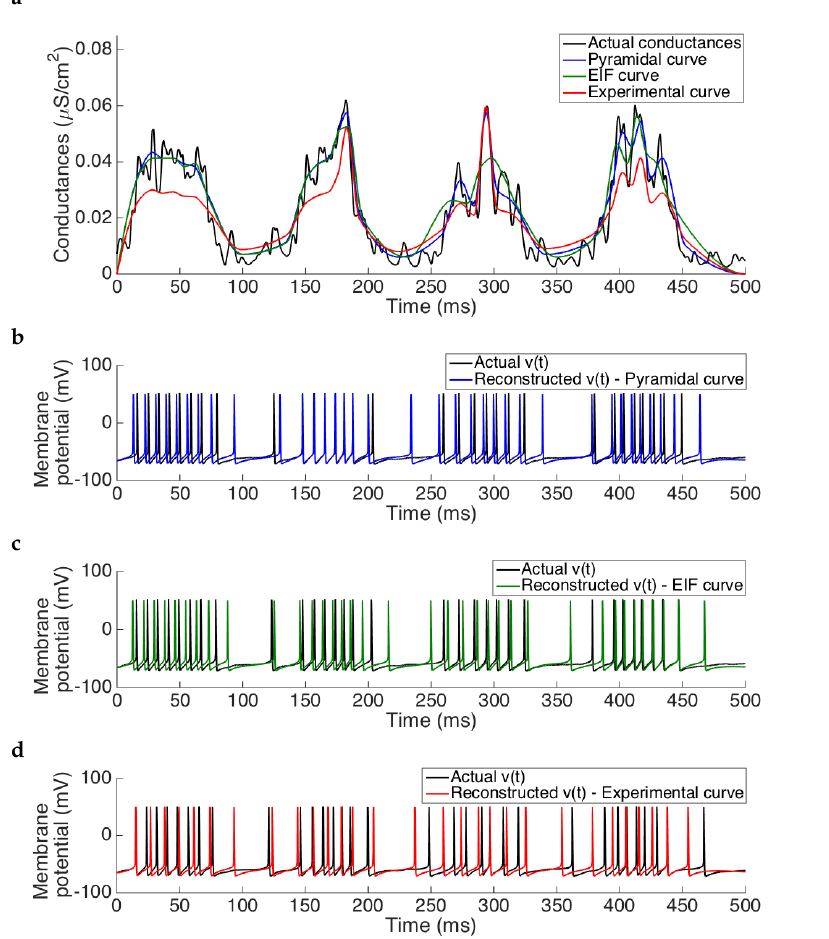
Figure 8. Results of the estimation procedure applied to a non-tonic membrane potential from a noisy pyramidal cell model. Panel ( a ) shows the prescribed conductances (black curve) and the estimated conductances using the same model (blue trace), the EIF model (green trace), and the experimentally fitted curve (red trace). Panels ( b – d ) show the reconstructed membrane potential when each of the mentioned estimated conductances in panel ( a ) has been, respectively, used as input to the base model (the noisy pyramidal cell